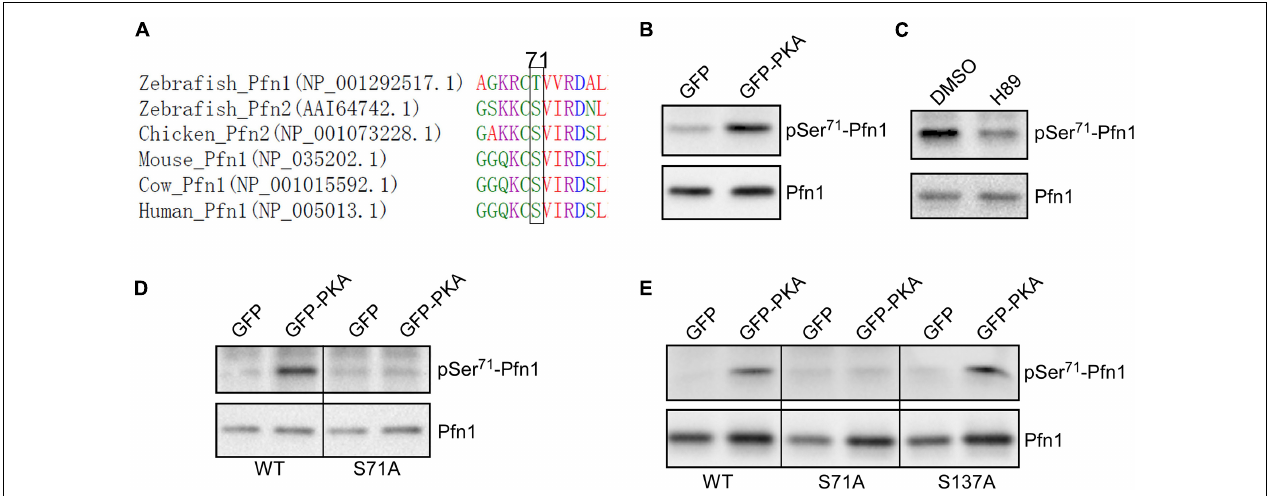
FIGURE 3 | Pfn1 is phosphorylated at Ser 71 by protein kinase A (PKA). (A) sequence alignment of Pfn1 and Pfn2 proteins from multiple vertebrate organisms shows that a phosphorylatable serine or threonine residue is highly conserved at position 71. (B) HEK293T cells were co-transfected with HA-tagged Pfn1 with GFP or GFP-PKA, followed by anti-HA immunoprecipitation. Pulldown samples were blotted using the pSer 71 -Pfn1 or pan Pfn1 antibodies. (C) HEK293T cells were transfected with HA-Pfn1 followed by the treatment with DMSO or 10 µ M H89 for 24 h. HA-Pfn1 was subsequently immunoprecipitated and blotted as in (B) . (D) HEK293T cells were co-transfected with HA-Pfn1(WT) or HA-Pfn1(S71A) with GFP or GFP-PKA, followed by immunoprecipitation and Western blot analysis as in (B, C) . (E) HEK293T cells were co-transfected with wild type or mutant HA-Pfn1 (S71A or S137A) with GFP or GFP-PKA, followed by immunoprecipitation and Western blot analysis as in (B–D)